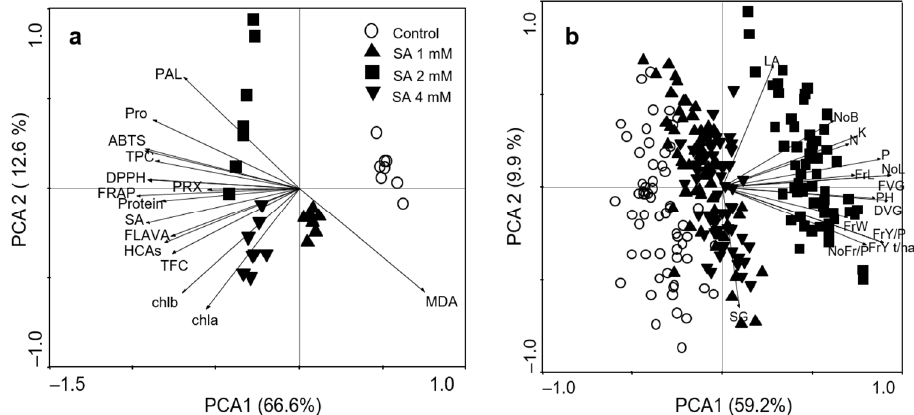
Figure 6. Principal component analysis (PCA) based on correlation matrix applied to biochemical ( a ) and agronomic ( b ) data sets. Each variable is represented by an arrow, and the longer its length, the greater its contribution to a given component. The angle between arrows indicates the degree of correlation among variables—the smaller the angle, the higher the correlation. Abbreviations: DVG, dry vegetative growth; FVG, fresh vegetative growth; FrL, fruit length; FrW, fruit weight, FrY t/ha, fruit yield tonnes per hectare; FrY/P, fruit yield per plant; LA, leaf area; LRWC, leaf relative water content; MSI, membrane stability index; NoB, number of branches; NoFr/P, number of fruit per plant; NoL, number of leaves; PH, plant height; SG, stem girth.